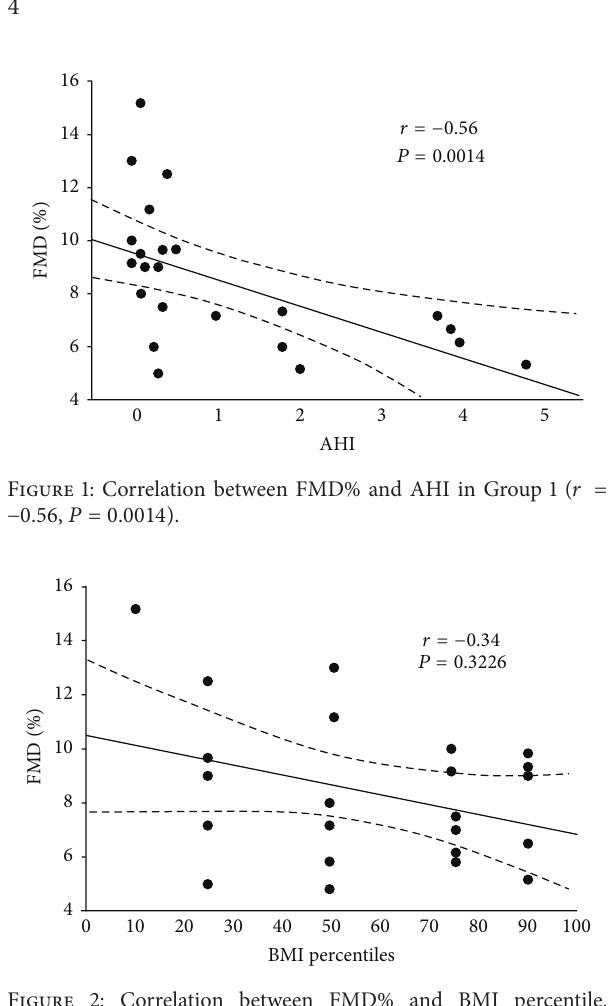
Figure 2: Correlation between FMD% and BMI percentile. ( 𝑟 = −0.34 , 𝑃 = 0.3226